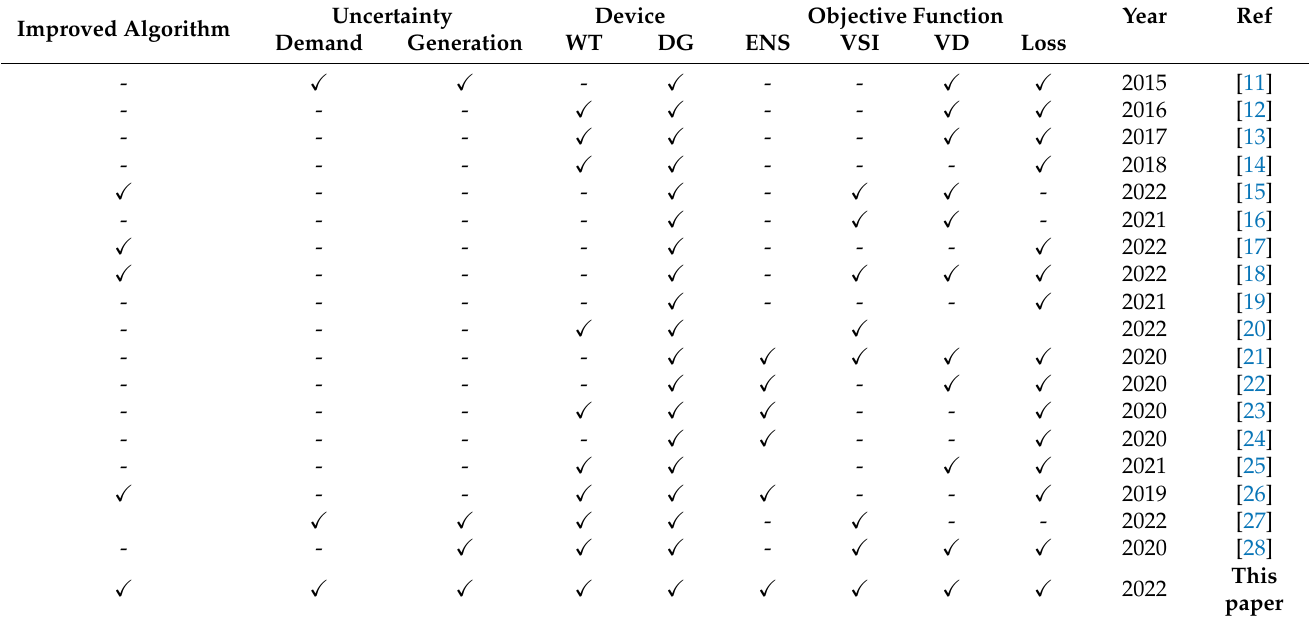
Table 1. Literature review